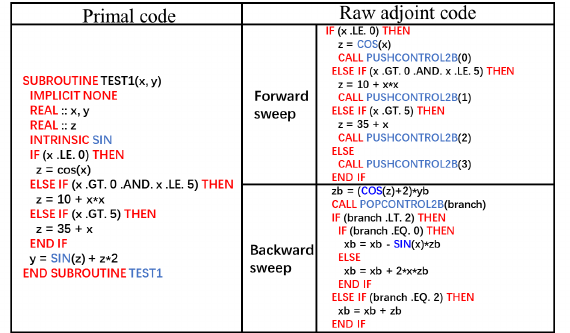
Figure 1. Case 1: the primal code and the raw adjoint code.